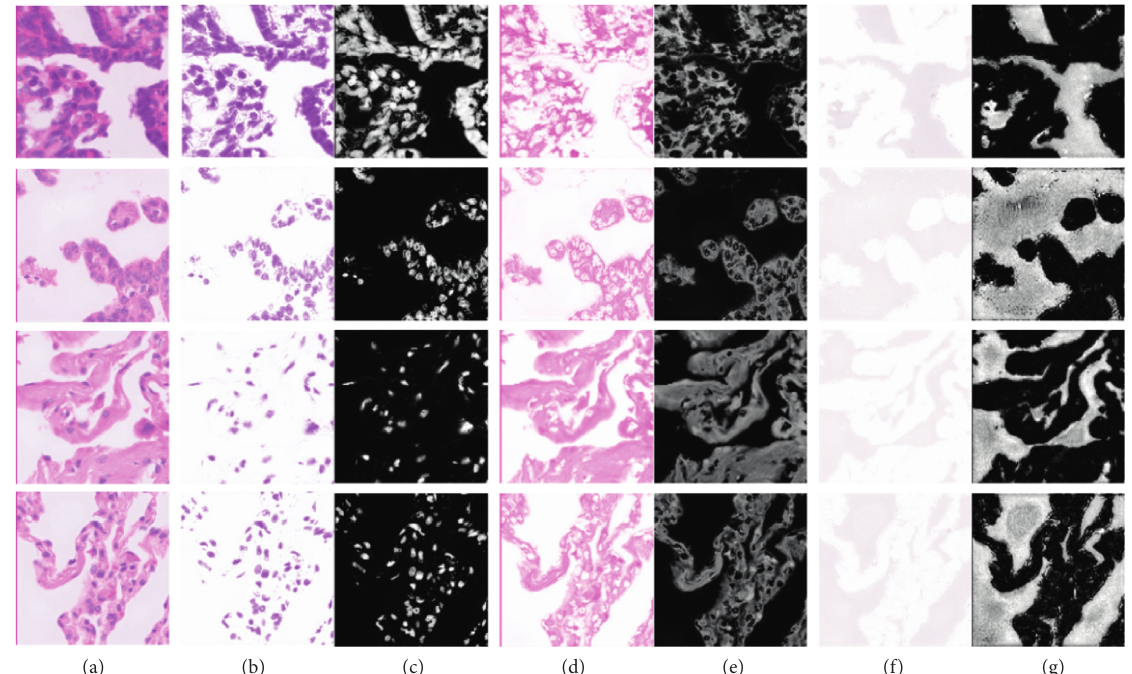
Figure 7: Stain separation result. The first column is the original image, the second column is the stain separation result of hematoxylin and the stain intensity map, and the third and fourth columns are the eosin and background stain separation results and stain intensity map. (a)